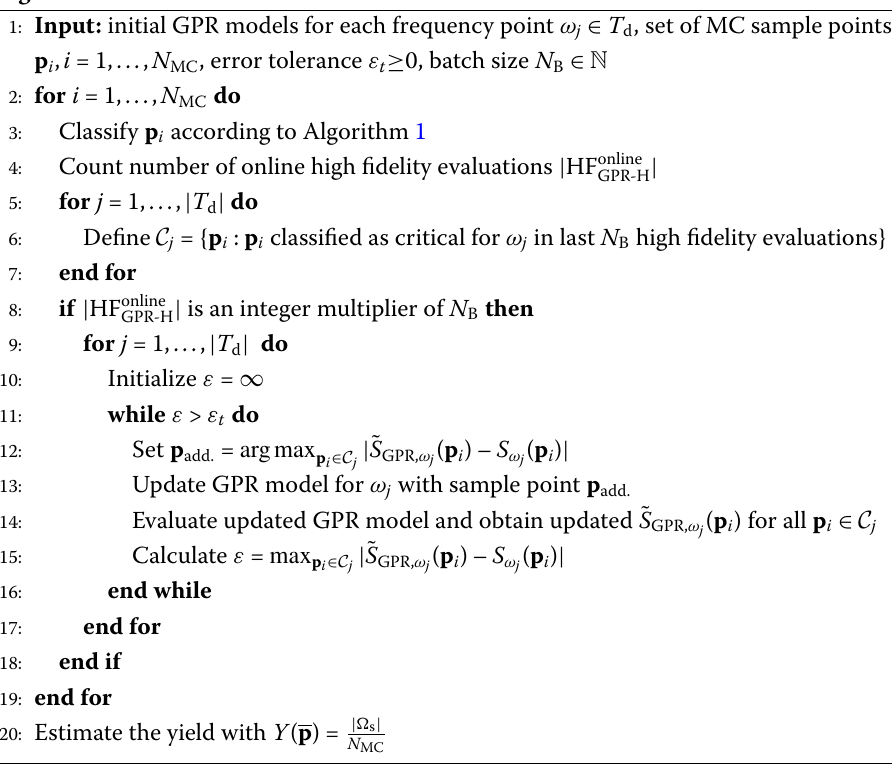
Algorithm 2 Yield estimation with